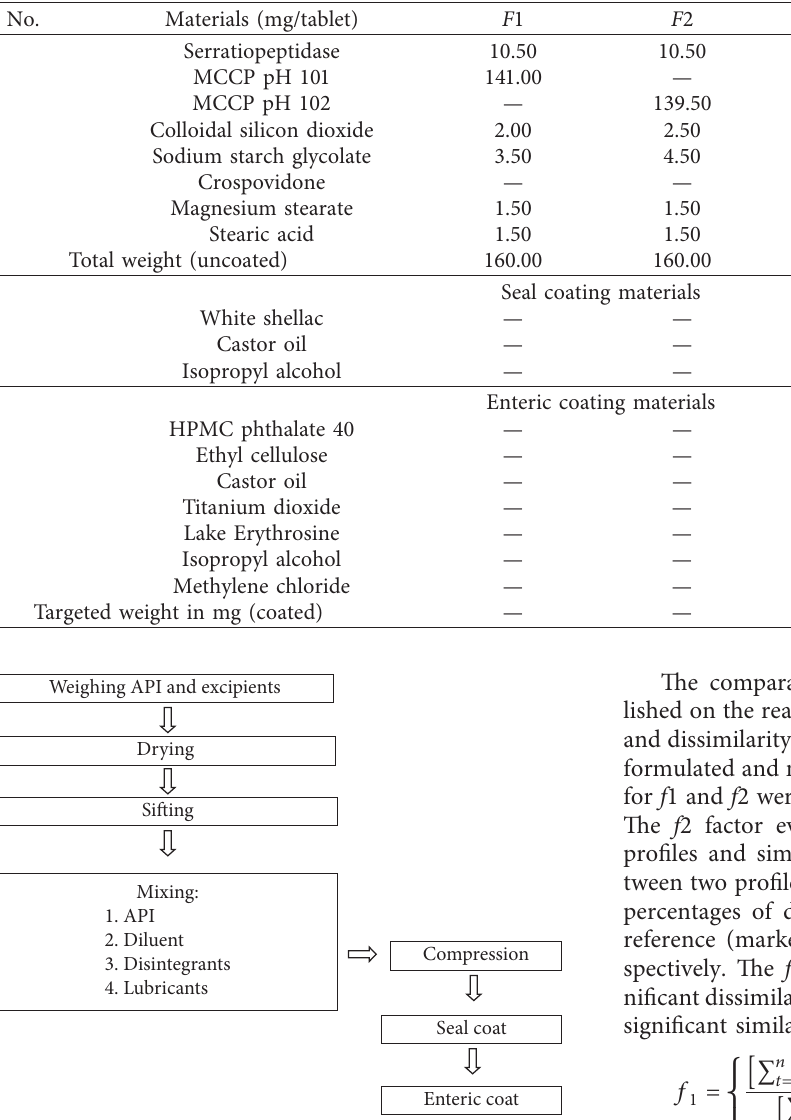
Figure 1: Manufacturing procedure of SRP